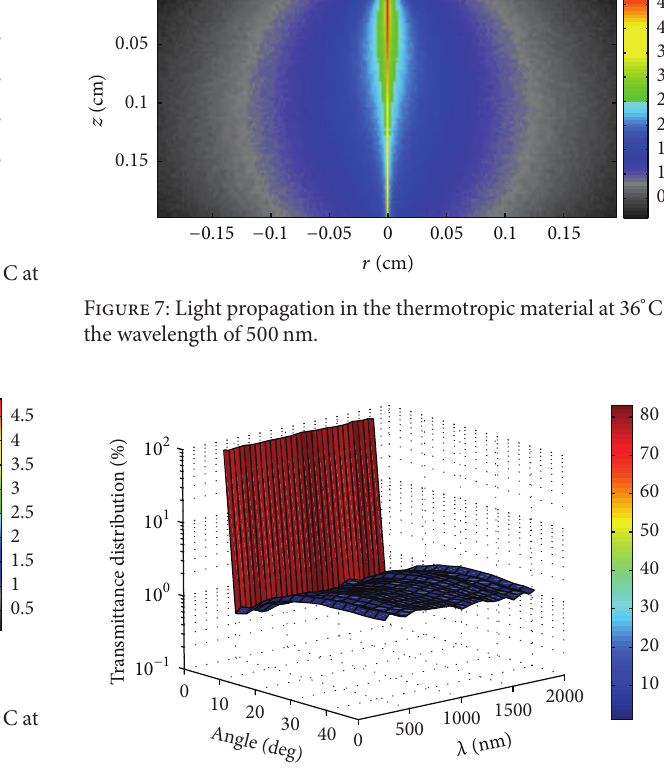
Figure 8: Spectral angular transmittance distribution of the ther- motropic material at 32 ∘